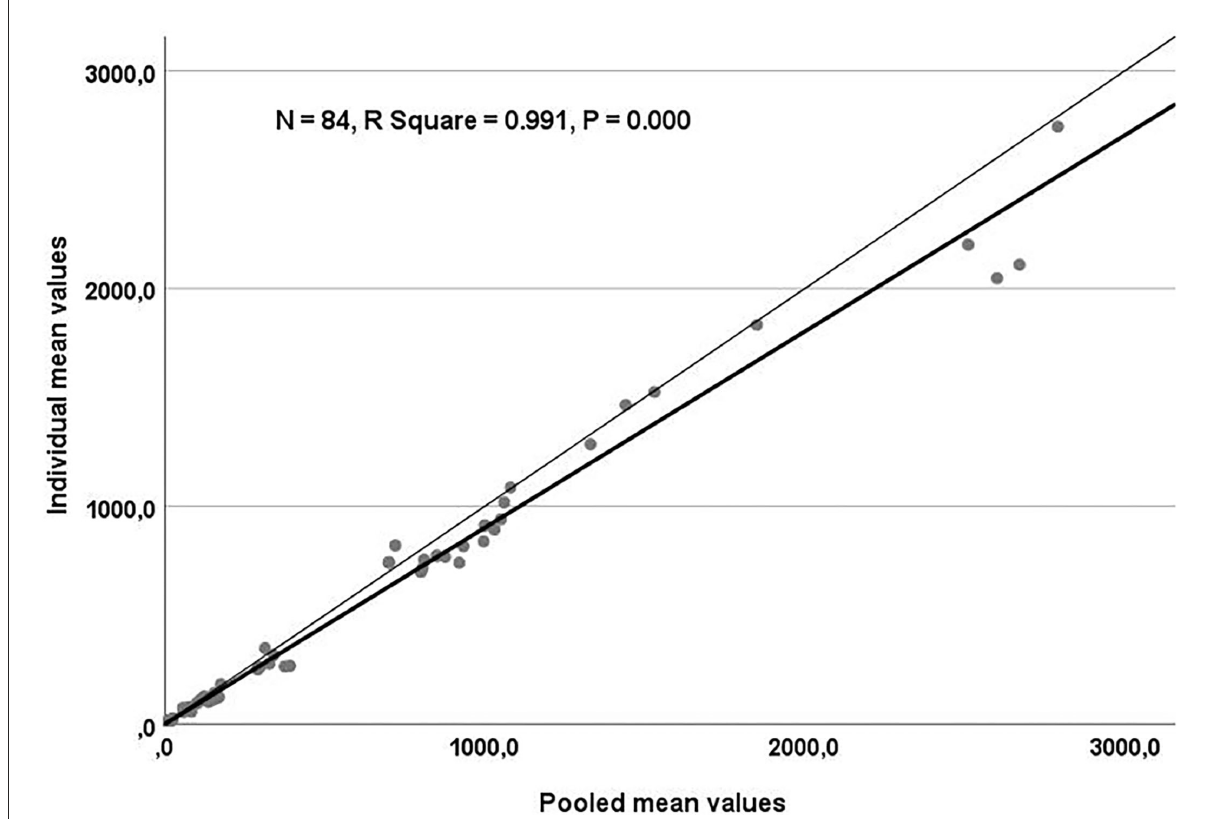
FIGURE1 Scatter plot for the regression analysis of essential trace elements. Values obtained in individual and pool samples were plotted and adjusted to a regression line (thick line). The thin line represents the identity line (Y =